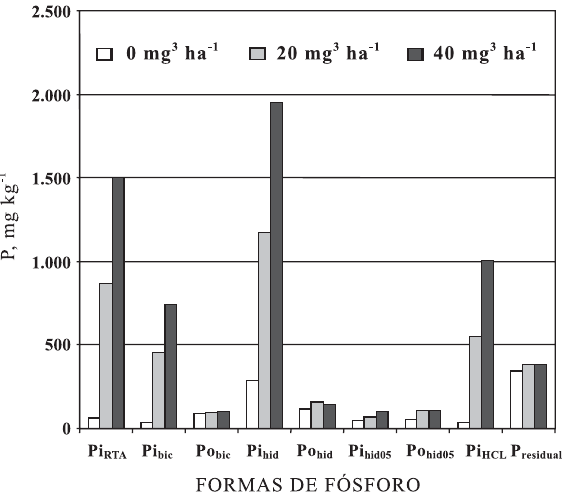
Figura 1. Formas de acumulação de fósforo por efeito da adição de dejeto líquido de suínos, considerando-se o somatório dos teores de fósforo das cinco